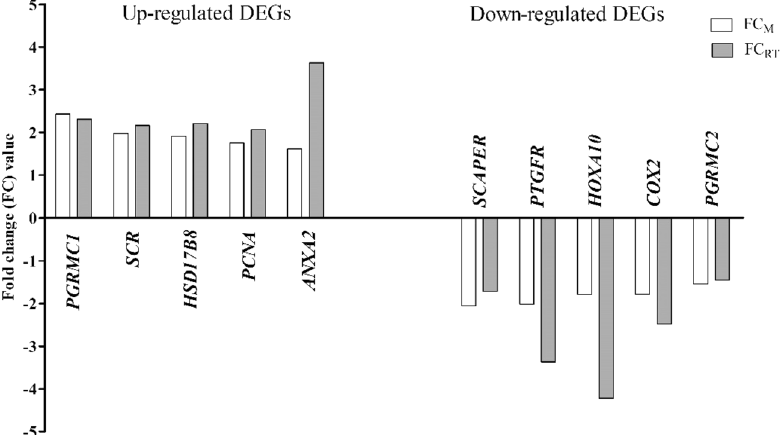
Figure 1. The validation of microarray results. The fold change values obtained with microarray analysis (FC M ) and Real-Time PCR (FC RT ) for validated up- and down-regulated genes are presented as bars. Figure generated in GraphPad Prism (trial version, https:// www. graph pad. com/ scien tific- softw are/